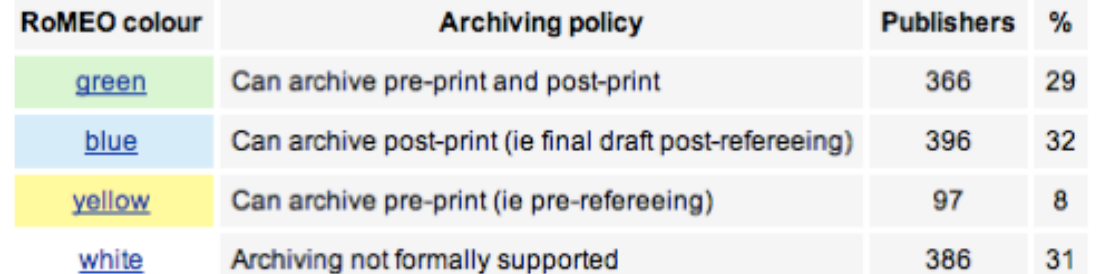
Figure 1 . RoMEO Database summary figures of journal publisher self-archiving policy (from http://www.sherpa.ac.uk/romeo/statistics.php